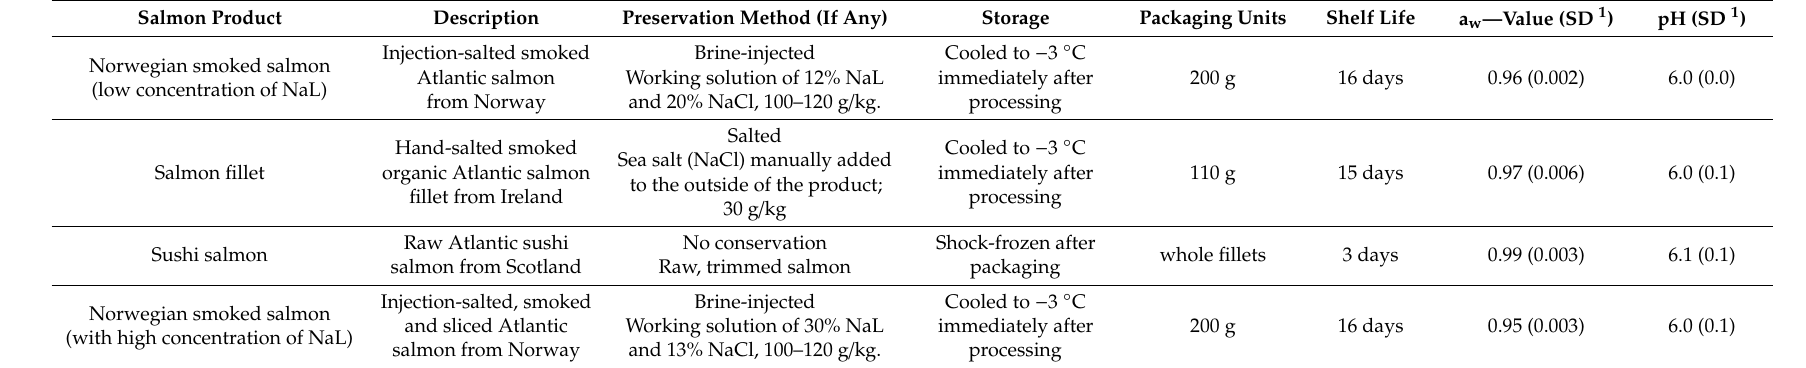
Table 2. Salmon products (Salmo salar) used in this